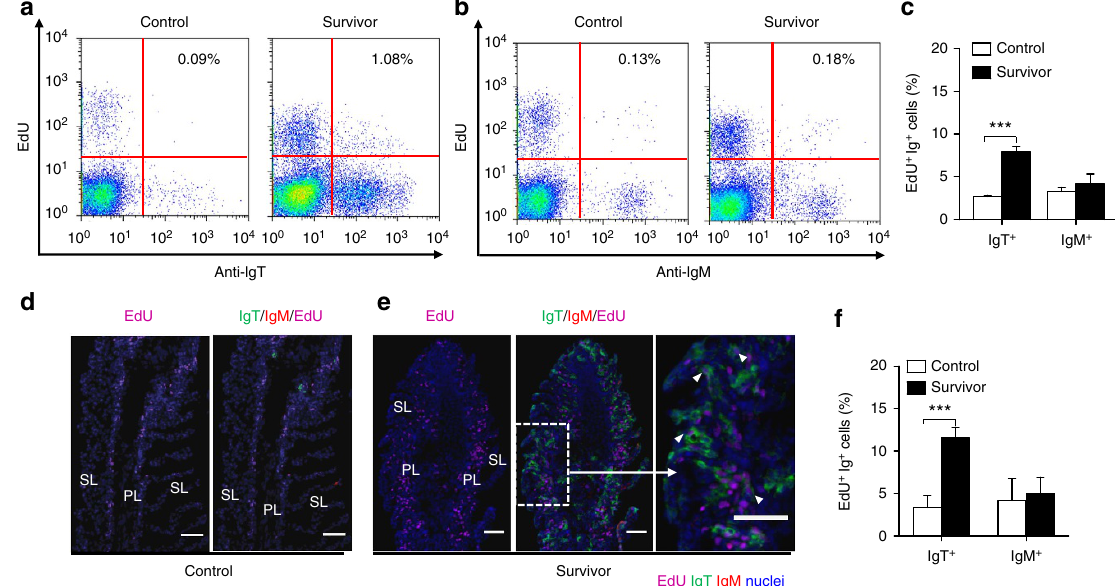
Figure 6 | Proliferative responses of IgT þ and IgM þ B cells in the gill of fish that survived Ich infection. ( a , b ) Representative flow cytometry dot plot showing proliferation of IgT þ B cells ( a ) and IgM þ B cells ( b ) in gill leucocytes of control and survivor fish. The percentage of lymphocytes representing proliferative B cells (EdU þ ) is shown in each dot plot. ( c ) Percentage of EdU þ cells from the total gill IgT þ or IgM þ B-cell populations in control or survivor fish ( n ¼ 12). ( d , e ) Immnofluorescence analysis of EdU incorporation by IgT þ or IgM þ B cells in gill of control ( d ) and survivor fish ( e ). Gill cryosections were stained for EdU (magenta), trout IgT (green), trout IgM (red) and nuclei (blue) detection ( n ¼ 9). Primary lamellae (PL) and Secondary lamellae (SL) are shown. White arrowheads point to cells double stained for EdU and IgT. Scale bars, 20 m m. Data are representative of at least three different independent experiments. ( f ) Percentage of EdU þ cells from the total gill IgT þ or IgM þ B-cell populations in control or survivor fish counted from d , e . Data in c and f are representative of at least three independent experiments (mean and s.e.m.). Statistical analysis was performed by unpaired Student’s t -test. *** P o 0.001. NATURE COMMUNICATIONS|7:10728|DOI: